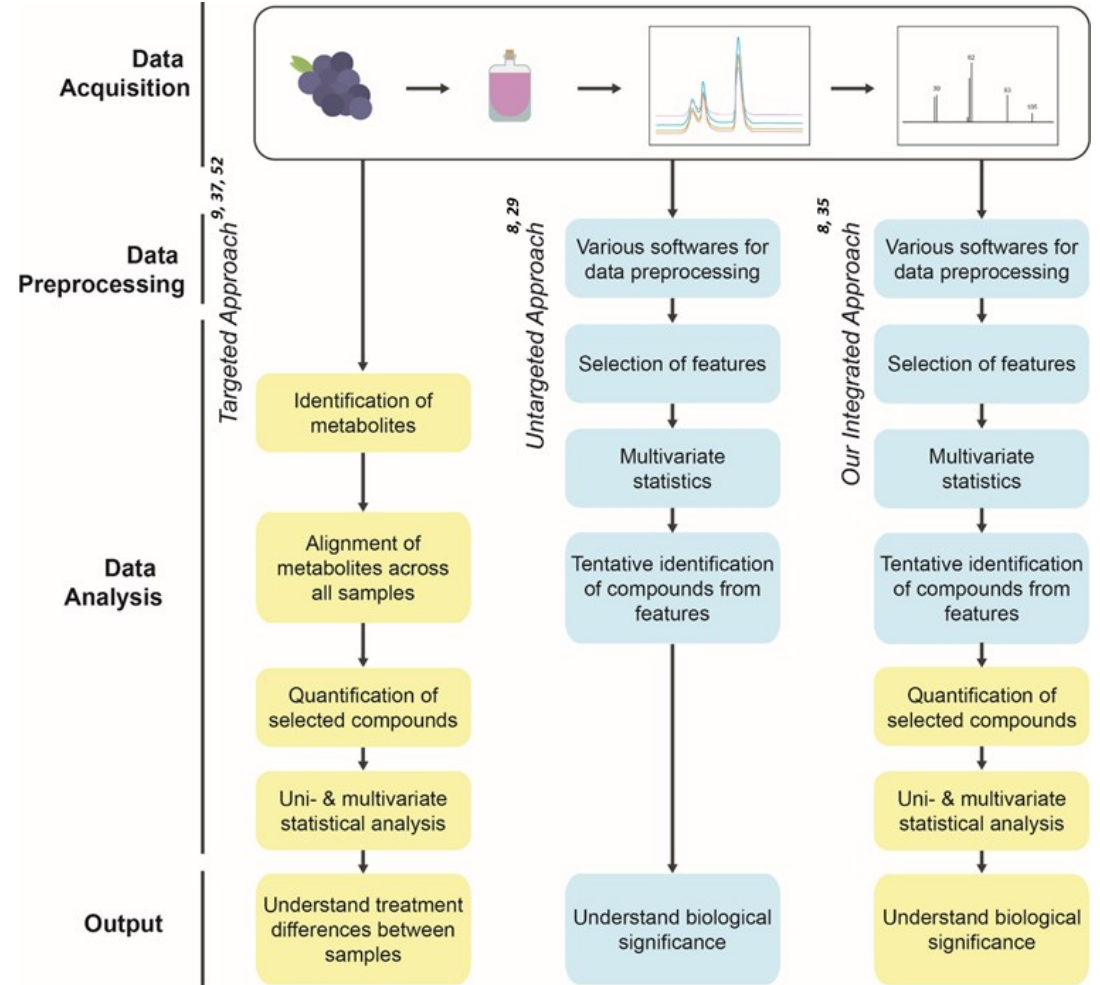
Figure 1. Comparative GC-MS based metabolomic approaches showing steps of conventional targeted approach, untar- geted metabolomic approach and our integrated metabolomic approach that uses parts of both targeted and untargeted approaches.